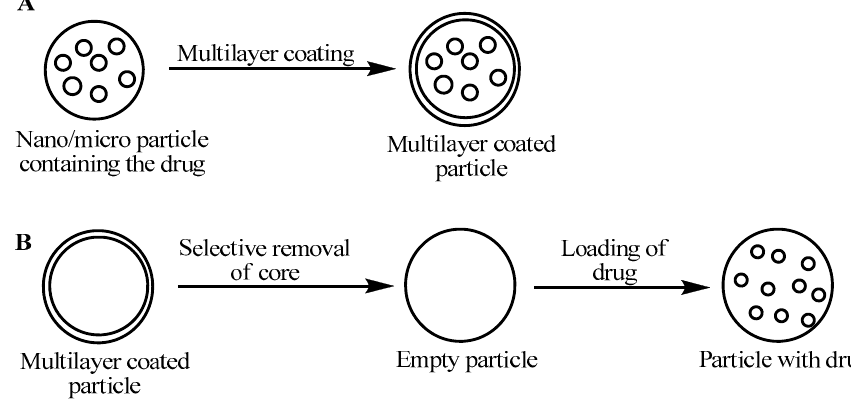
Figure 6. Methods to obtain multilayer polymer films of drug delivery systems. ( A ) Multilayer coating on particle with encapsualted drug; ( B ) sacrificial removal of core followed by drug loading.